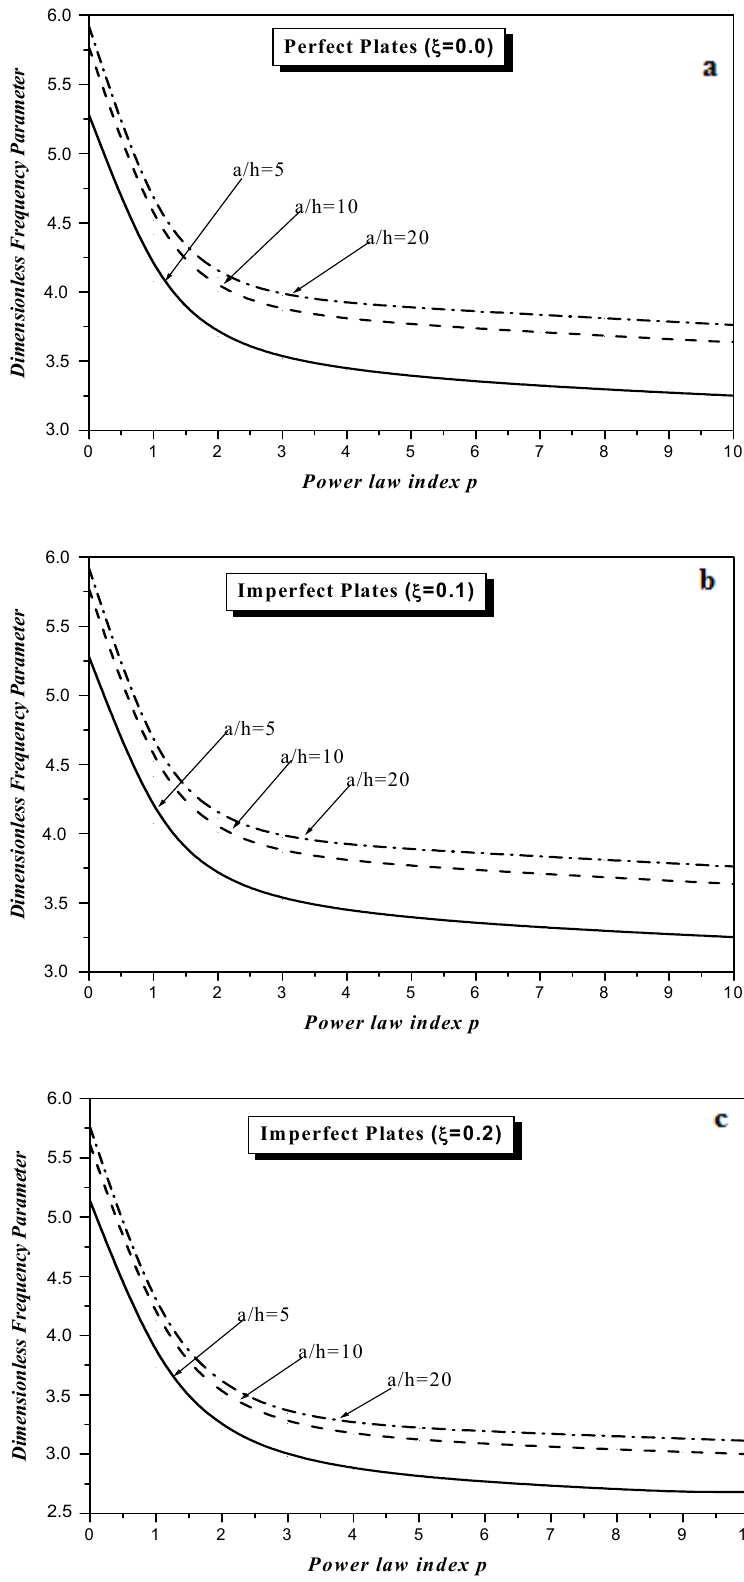
Figure 4. The dimensionless frequency ω vs. the power index p for FG plates with a different porosity factor ξ and thickness ratio a / h .